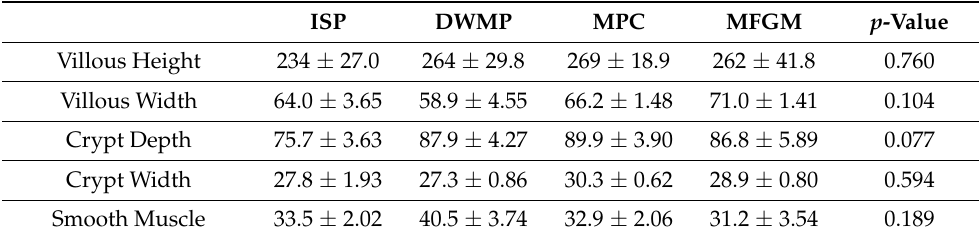
Figure 1. Representative sections from H&E-stained small intestine slides scanned at 20 × magnification. Black bars represent distance measured for determination of villi length. ISP, isolated soy protein; DWMP, dried whole milk powder; MPC, milk protein concentrate; MFGM, milk fat globule membrane. Table 5. Small intestine morphology.